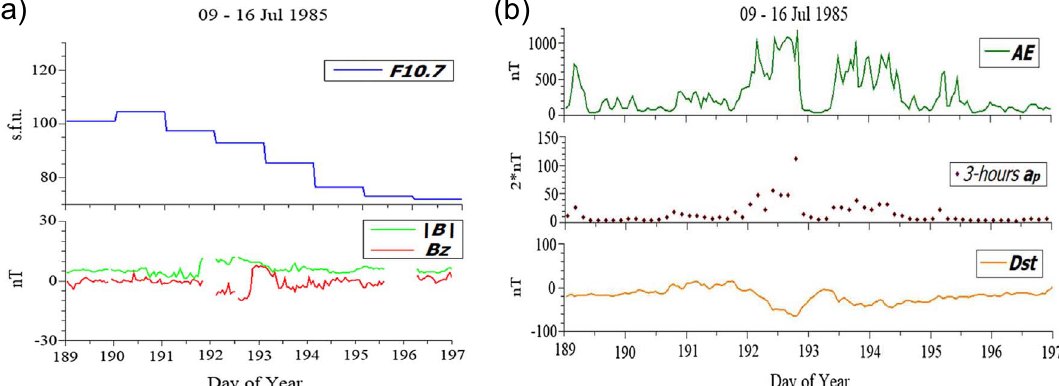
Fig. 4. In panel (a), from up to down, are reported the Solar fl ux F10.7 from 09 to 16 July 1985, and the IMF magnitude and Z component evolution for the same period. In panel (b), from up to down, are described respectively the AE index, the a p index and the Dst index, from 09 to 16 July 1985. (The hourly AE index data are retrieved through the Kyoto AE index service http://wdc.kugi.kyoto-u.ac.jp/dstae/index.html. Three-hour a p data are provided by NOAA ftp://ftp.ngdc.noaa.gov/STP/GEOMAGNETIC_DATA/INDICES/KP_AP. Dst and Solar data